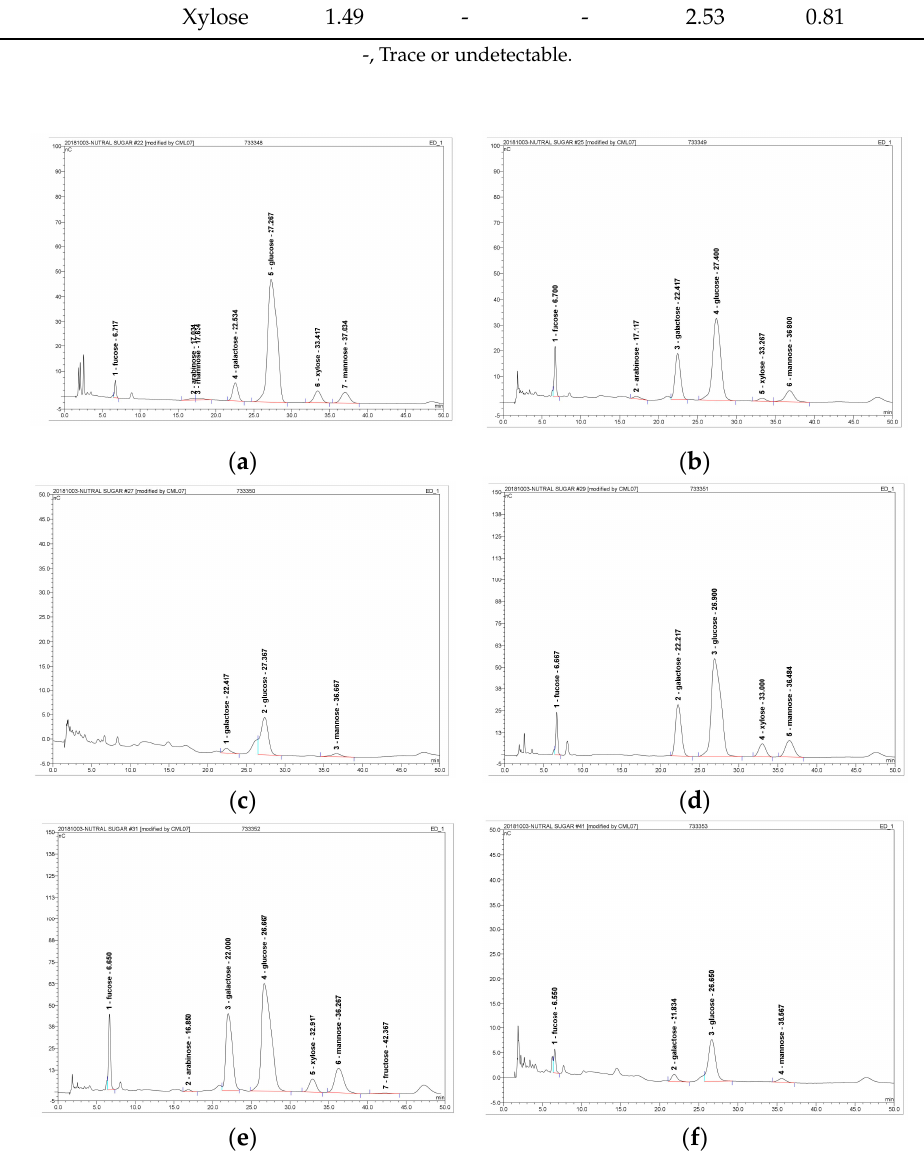
Figure 4. High-performance anion-exchange chromatography with pulsed amperometric detection (HPAEC-PAD) of monosaccharides composition: ( a ) FVY-40, ( b ) FVY-60, ( c ) FVY-80, ( d ) FVW-40, ( e ) FVW-60, and ( f ) FVW-80.